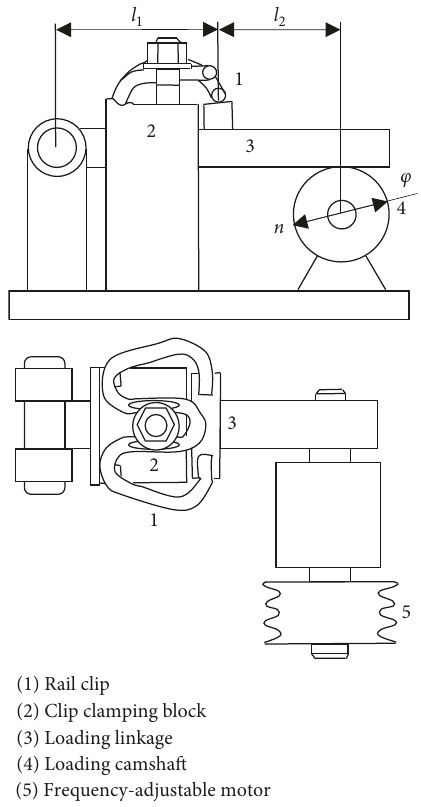
Figure 15: High-frequency fatigue test system for rail